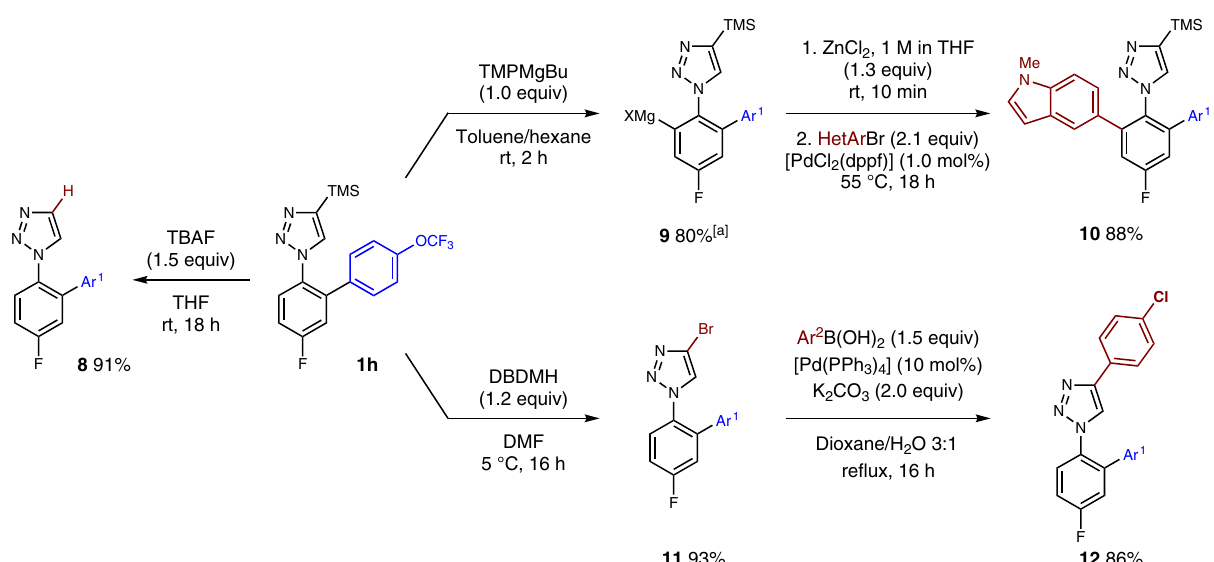
Fig. 5 Late-stage modi fi cations. [a] Metalation yields was determined by 1 H-NMR analysis of D 2 O-quenched reaction aliquots. All other yields refer to isolated compounds. HetAr = N -Me-5-indolyl, Ar 1 = 4-OCF 3 -C 6 H 4 , Ar 2 = 4-Cl-C 6 H 4 .